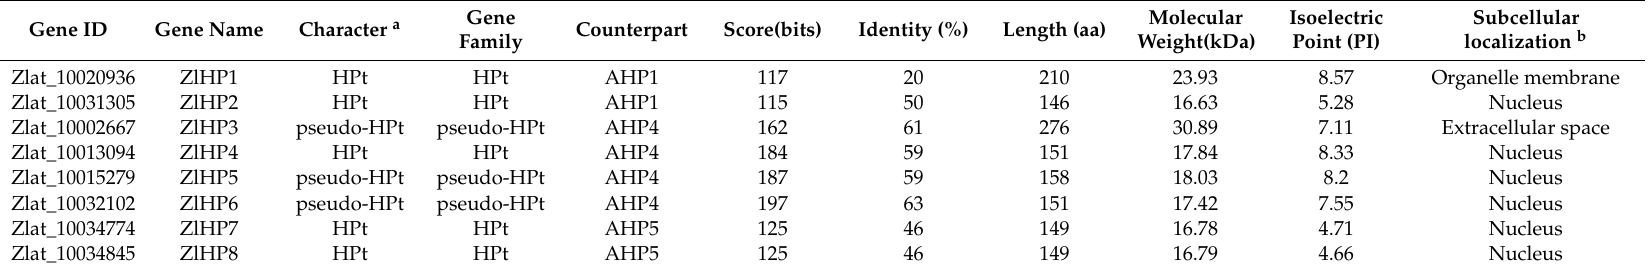
Table 2. Histidine phosphotransfer proteins (HP) proteins in Z. latifolia